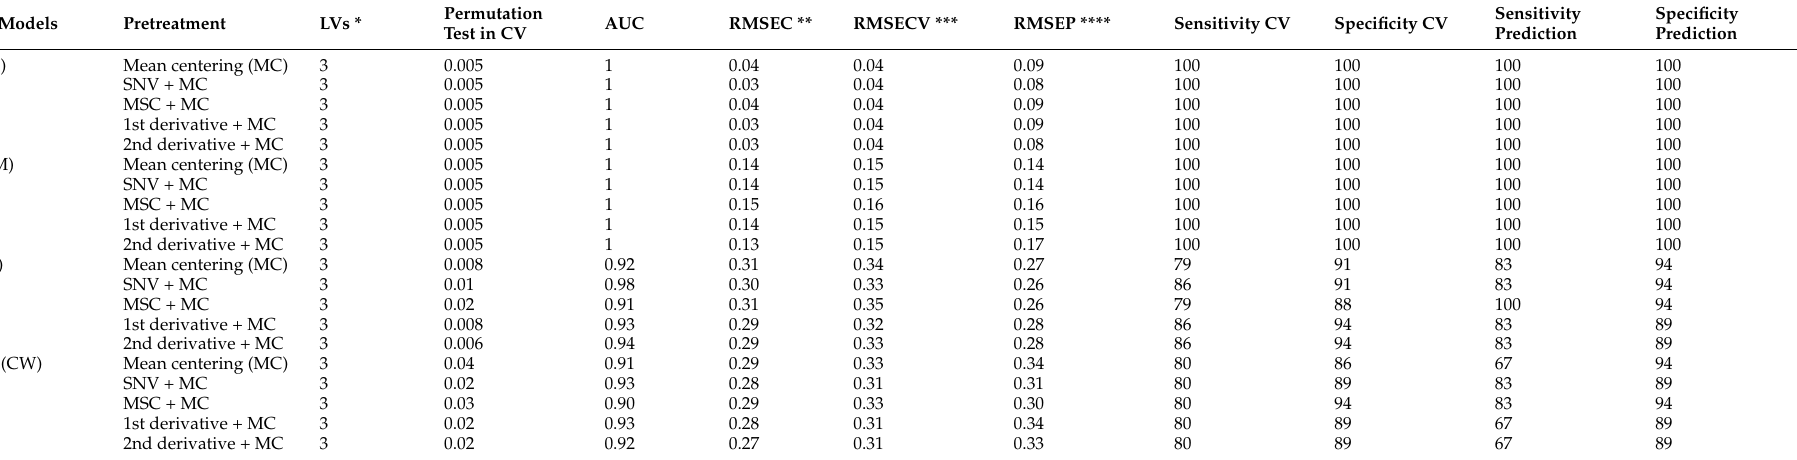
Table 3. Results of PLS-DA models applied on Cymbopogon dataset for both cross-validation of the calibration set and prediction of test set using different pretreatment methods.